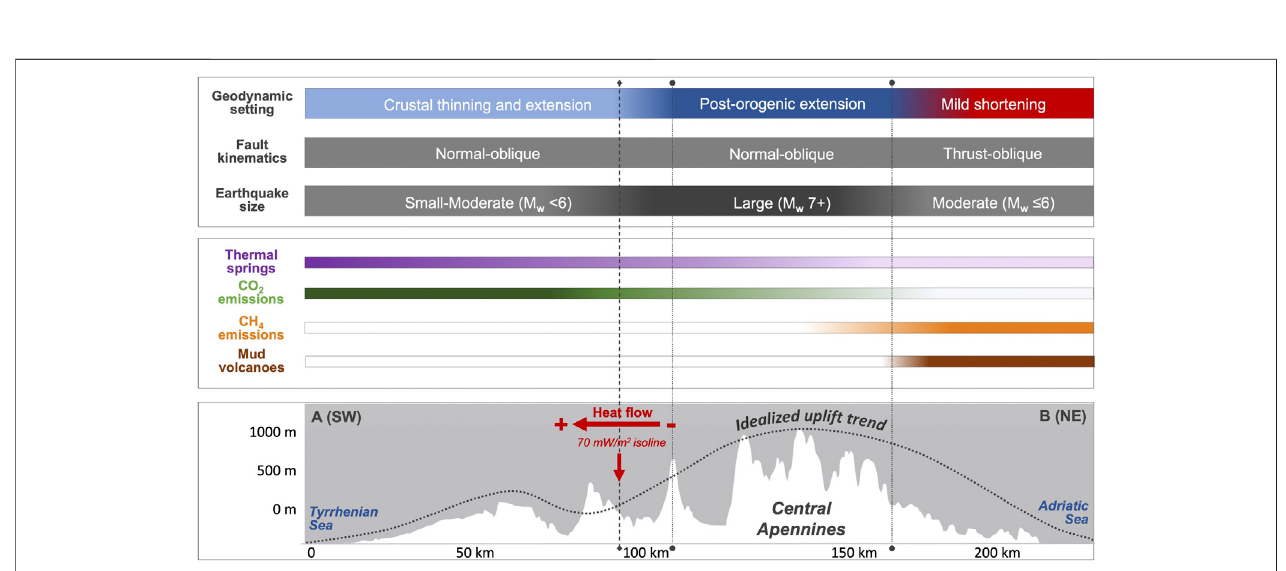
FIGURE13| Syntheticwork fl owofthisstudy; from theinputdata, todata selection, tothe fi nalinferences. Seetext forfurther details(refer tothe Tacklingan Old Question Through a New Approach and Newly Organized Observations , Selecting the Terms of Comparison and Correlations and Anticorrelations Sections, respectively from the leftmost to the rightmost